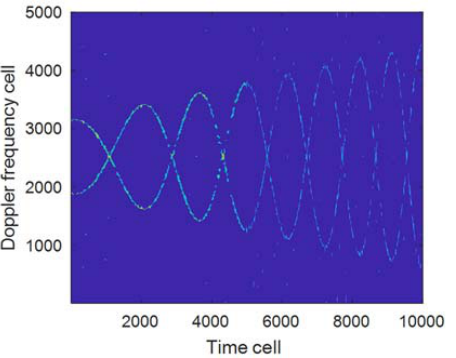
Figure 7. Time-frequency results corresponding to g